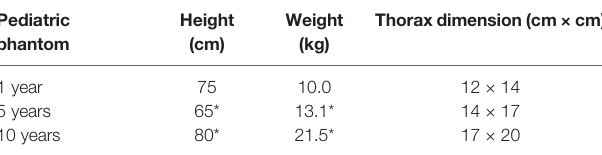
TABLE 1 | Anatomical references of CIRS ATOM ® 1-, 5-, and 10-year-old pediatric anthropomorphic phantoms used in this study, based on ICRP 23 (22), ICRU 48 (23) and available anatomical reference